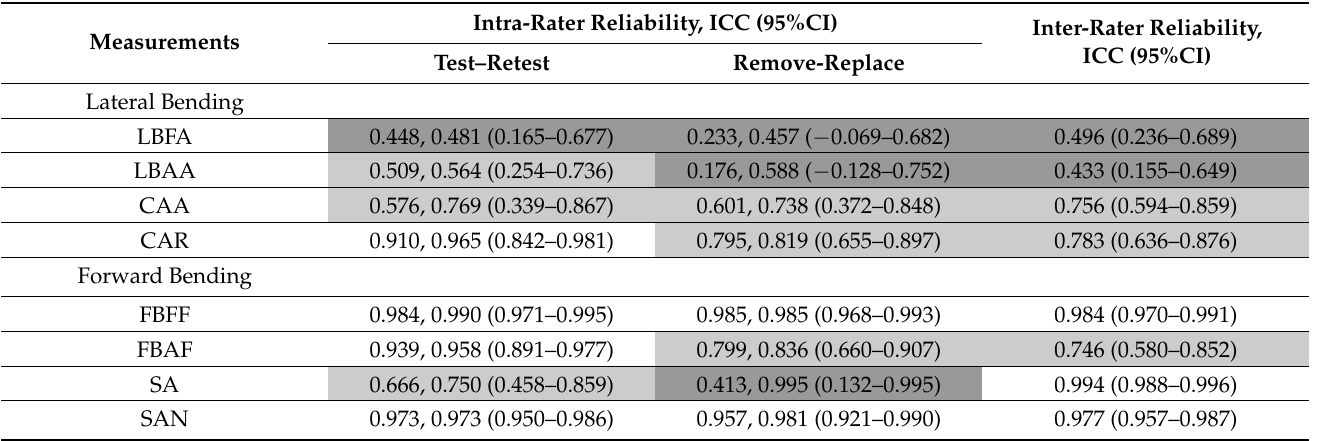
Table 3. Inter-rater and intra-rater reliability of lateral and forward bending